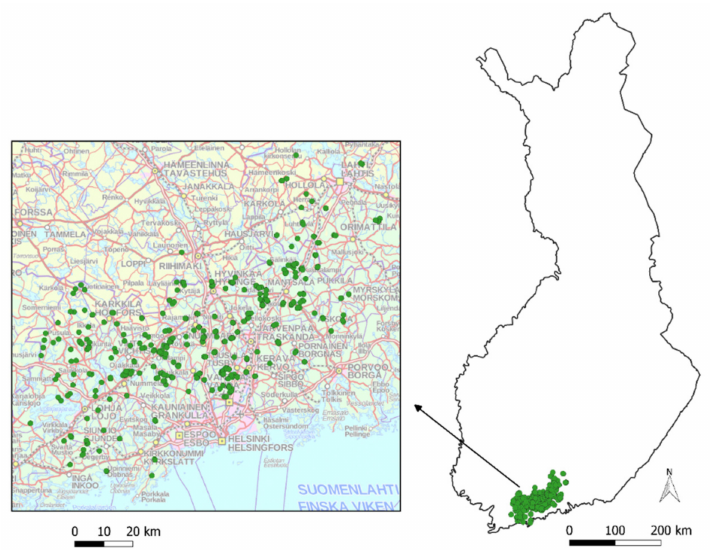
Figure 3. The locations of the harvested study stands. Base map © National Land Survey of